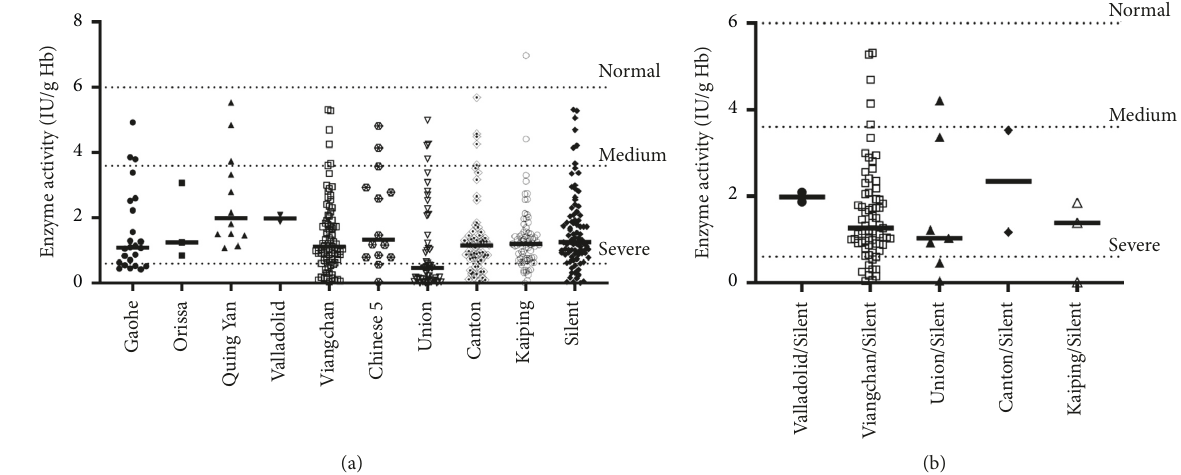
Figure 4: Distribution of G6PD activities according to mutation types. Only variant groups in which there were ≥ 2 representatives